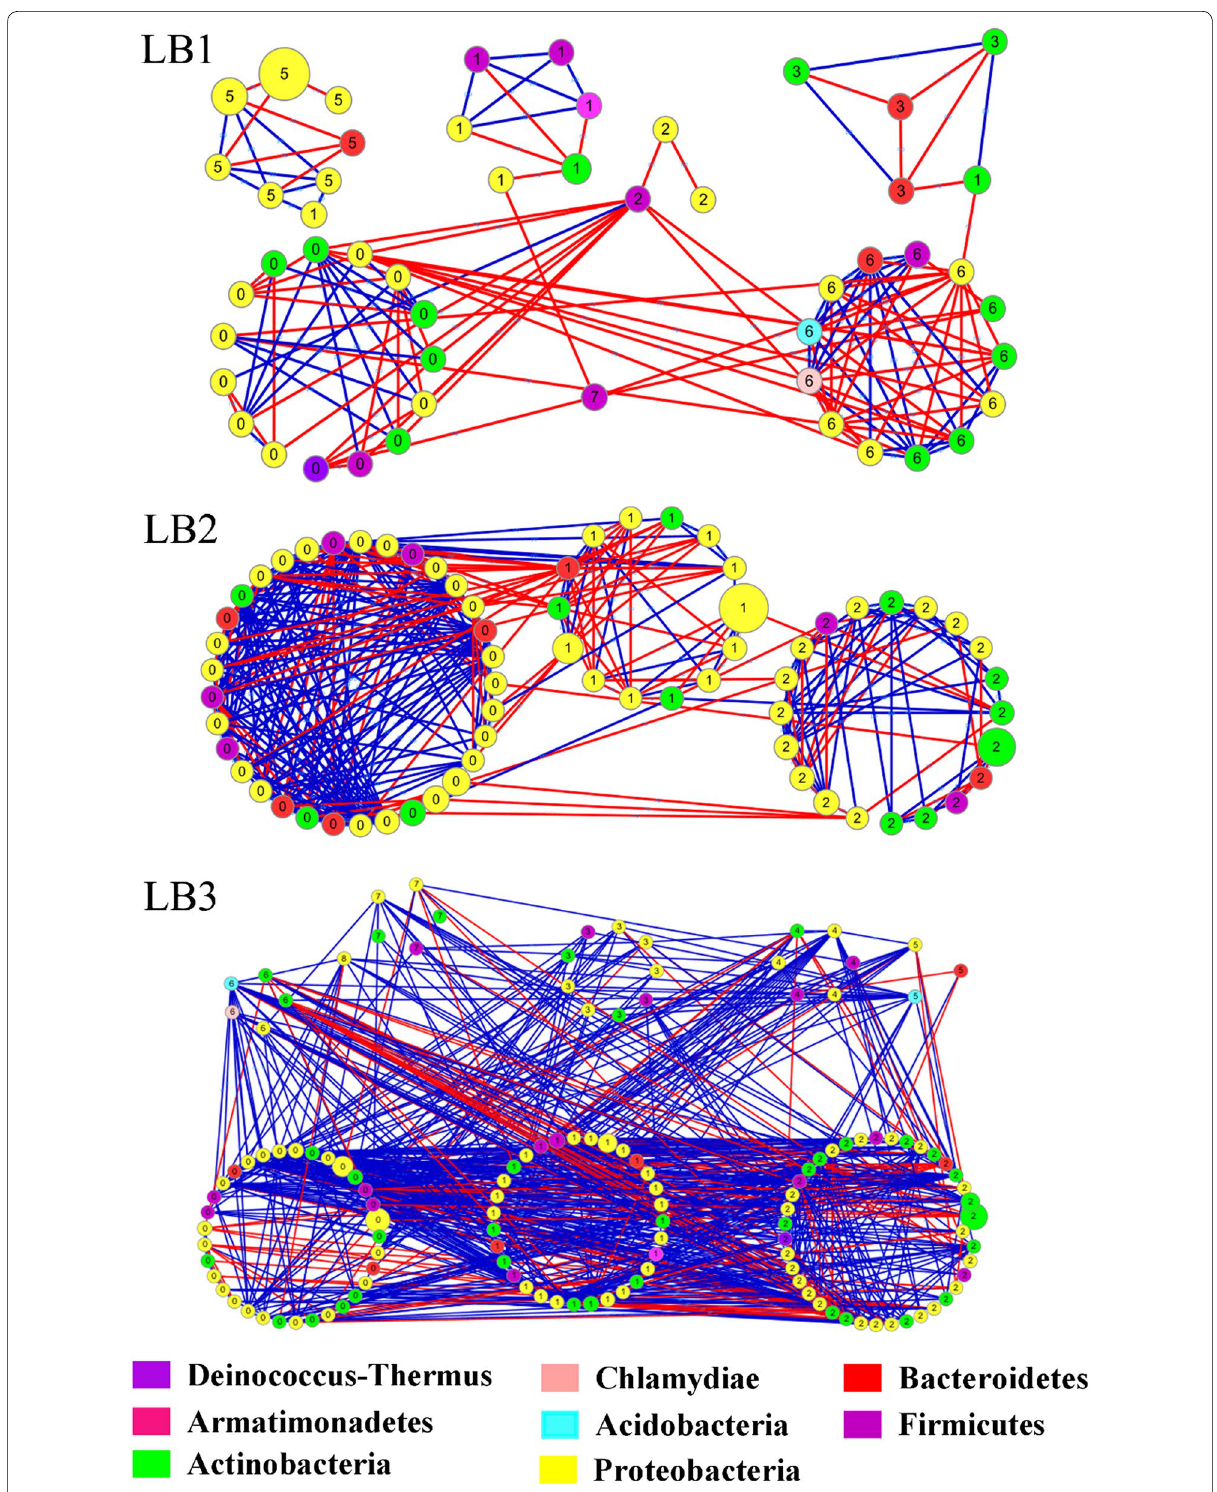
Fig. 3 Phylogenetic molecular ecological networks (pMENs) of bacterial communities under different disease severities. Modules with > 5 nodes were obtained for bacterial groups (LB1, LB2 and LB3), respectively. The links between two nodes show the correlation (red: positive, blue: negative). The size of circle indicate the relative abundance of the OTU. The number in the center of circle represents the modules to which these OTUs